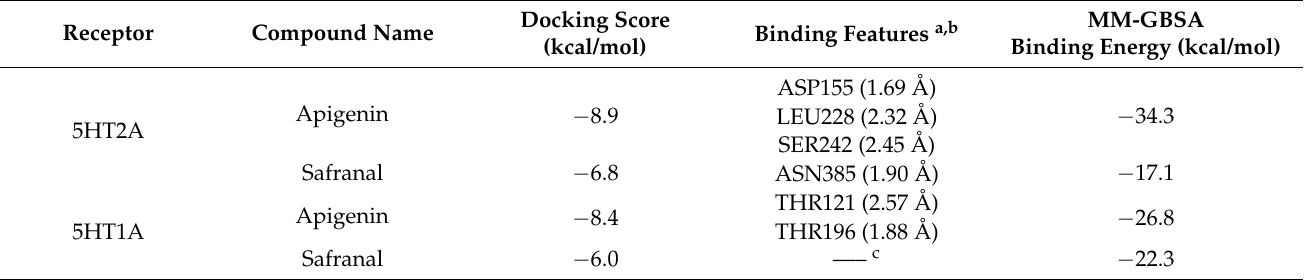
Figure 1. ( a ) A 3D representation of the native structure (gray) and portended docking pose (blue). ( b ) The 2D molecular interactions of the anticipated docking pose of 8NU ligand with 5HT2AR. Table 1. Calculated docking scores, binding features, and binding affinities during a 200 ns MD simulation of apigenin and safranal against 5HT1AR and